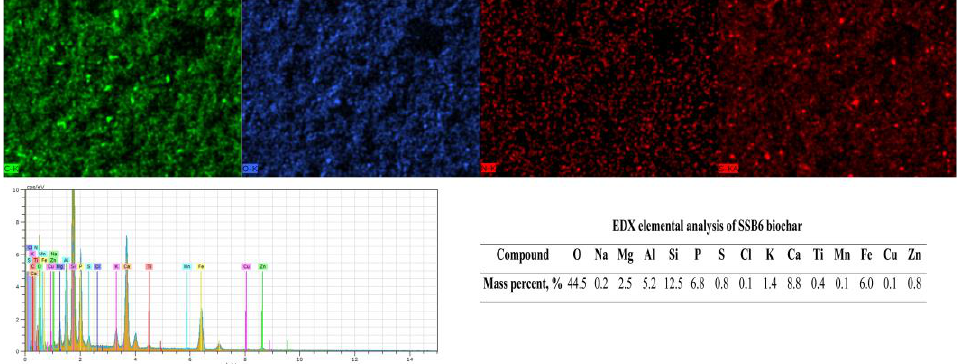
Figure 7. SEM-EDX analysis and mapping results of SSB6 biochar.